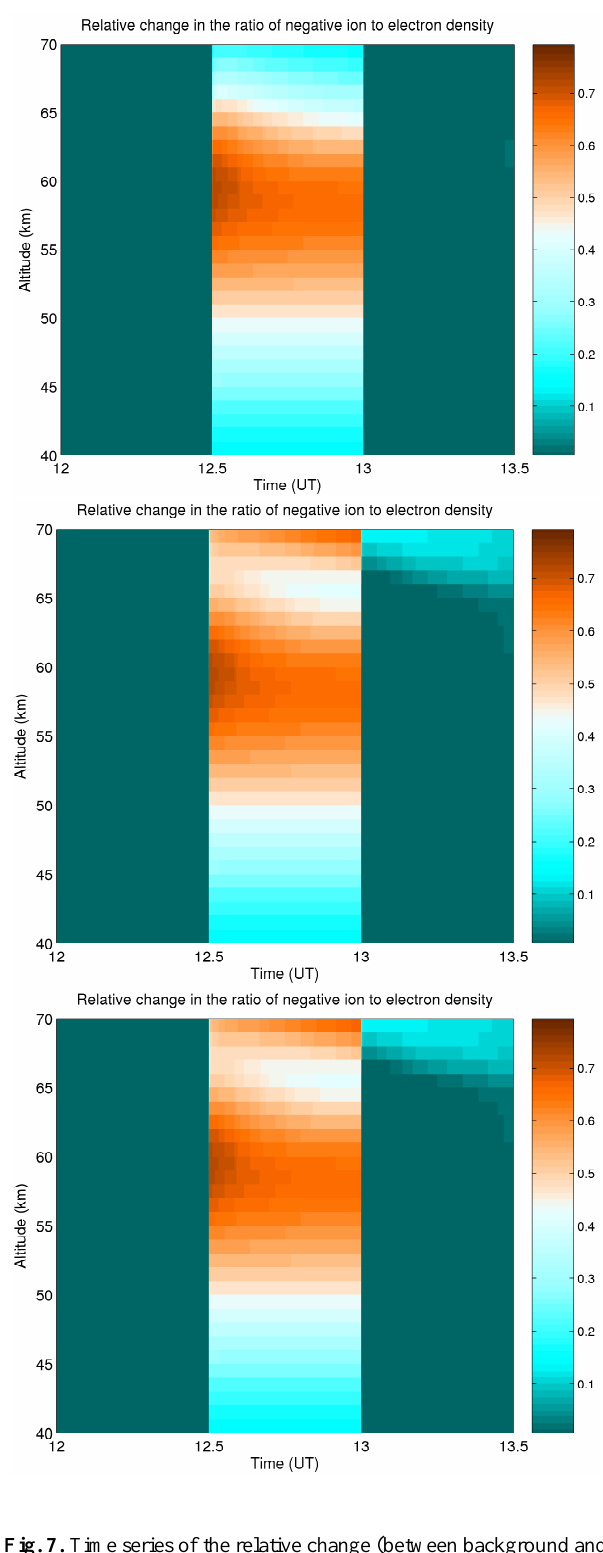
Fig. 7. Time series of the relative change (between background and 8-MHz heating noontime runs) in the ratios of negative ion to elec- tron density. 1: The quiet-day case; 2: The electron precipitation case; 3: The proton precipitation